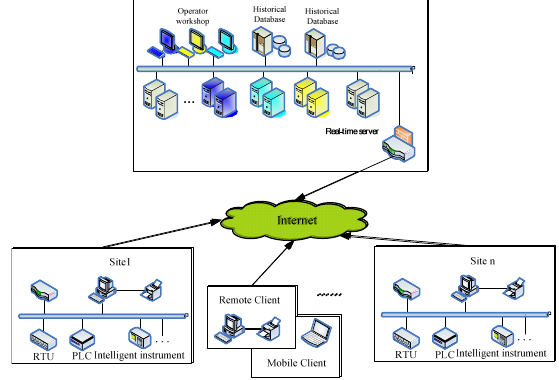
Figure1. The structure of SCADA